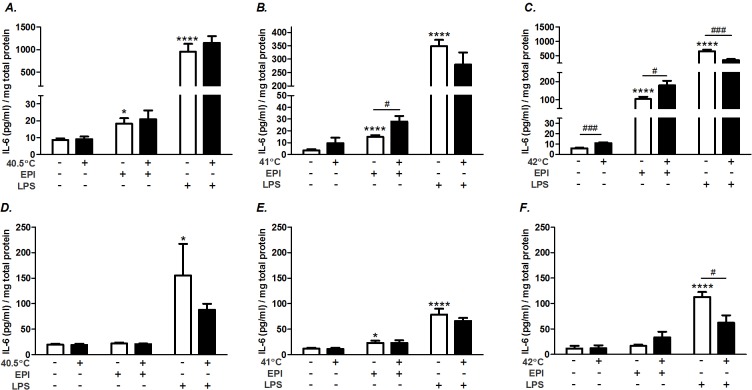
Hyperthermia differentially regulates IL-6 protein.Myotubes were maintained at 37°C or exposed to 40.5°C (A, D), 41°C (B, E) or 42°C (C,F) for 1 h and then maintained at 37°C for 5 h. Select cultures were co-stimulated with EPI, or LPS. Supernatants (A,B,C) and cell lysates (D,E,F) were sampled for IL-6 protein analysis by ELISA. Values are expressed relative to the total protein content from cells in each well. Results from multiple cultures, four independent experiments, two samples per experiment; ANOVA. * Comparison vs. 37°C control; # comparison during matching experimental treatments 37 vs. 42°C; * or # (P<0.05), *** or ### (P<0.001), and **** (P<0.0001).